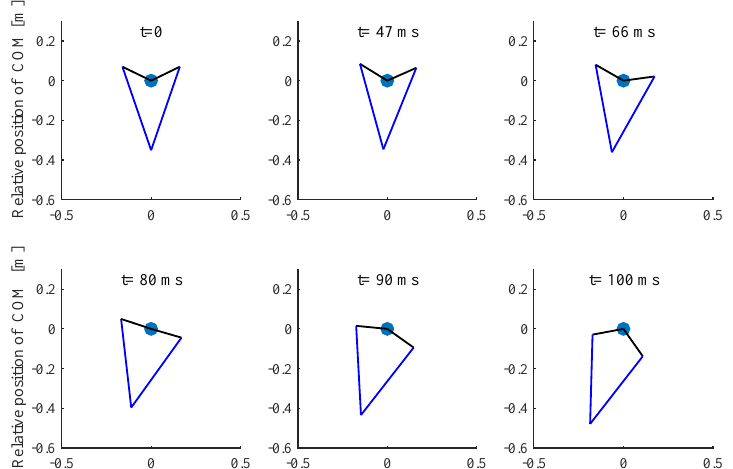
Figure 9. The results of vertical jump.